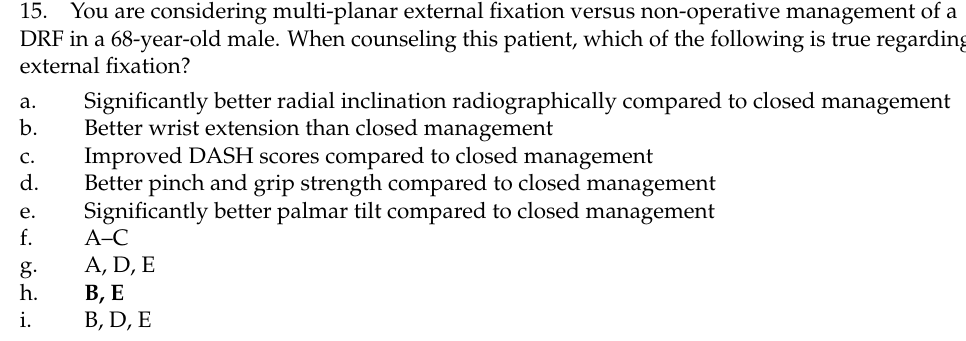
14. While reducing a grossly unstable DRF, you find that supinating the arm lessens re-displacement of your reduction. In the below figure, identify and name the muscle that was contributing to re-displacement of your reduction and which was neutralized by supination.